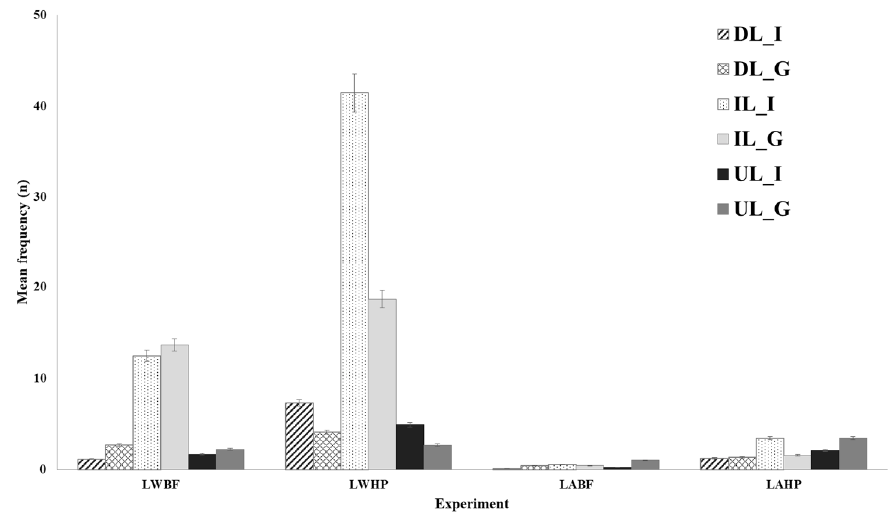
Figure 3. Mean frequency ( ± SEM) for the wood (LW) and acrylic (LA) L-structures use by L. bocagei (n = 45) for base-flow (BF) and hydropeaking (HP) events at the three structures areas: Downstream (DL_I and DL_G) and upstream (UL_I and UL_G) approaches and inside the L-structure (IL_I and IL_G) (I: Individual; G: Group).